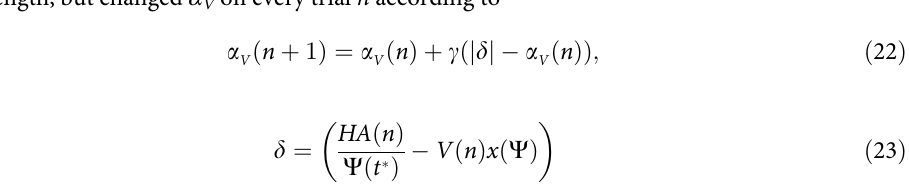
PLOS Computational Biology | https://doi.org/10.1371/journal.pcbi.1005796 November 2,